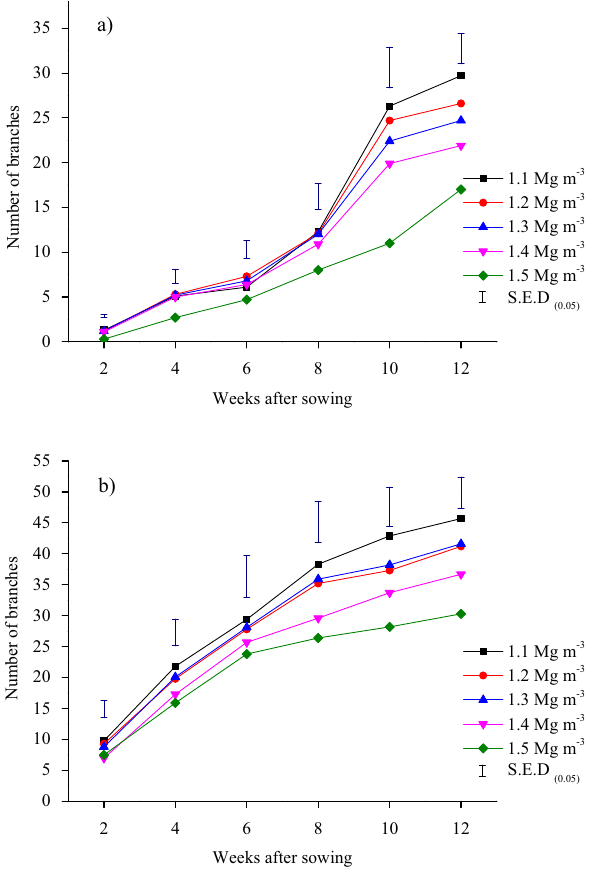
Figure 3: Number of branches of groundnut as in fl uenced by soil compaction in: ( a ) year 1 and ( b ) year 2.